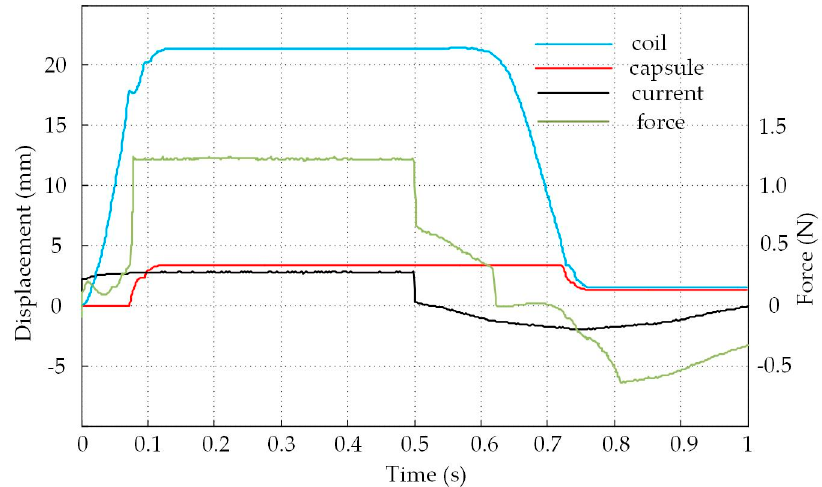
Figure 11. Measured current profile, coil, and capsule displacement waveforms in one period.